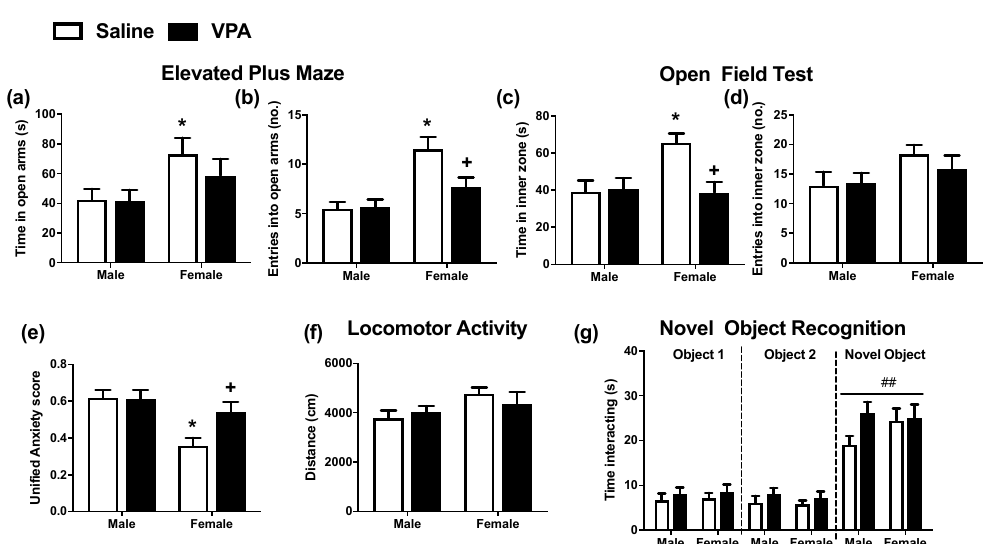
Figure 2. The effect of prenatal VPA exposure on anxiety-like behaviour and recognition memory in male and female adolescent rats. ( a ) Time in open arms and ( b ) number of entries into the open arms during the EPM (n = 12 per group). ( c ) Time in inner zone and ( d ) number of entries in the inner zone during the OFT (n = 12 per group). ( e ) Unified behavioural anxiety score (n = 12 per group). ( f ) Locomotor activity in open field arena (n = 12 per group) and ( g ) time interacting with familiar and novel objects during the NOR trial (n = 11 to 12 per group). Data expressed as mean + SEM. * p < 0.05 vs. saline-exposed males; + p < 0.05, vs. saline-exposed females. ## p < 0.01 vs. corresponding group interacting with object 1 and 2.